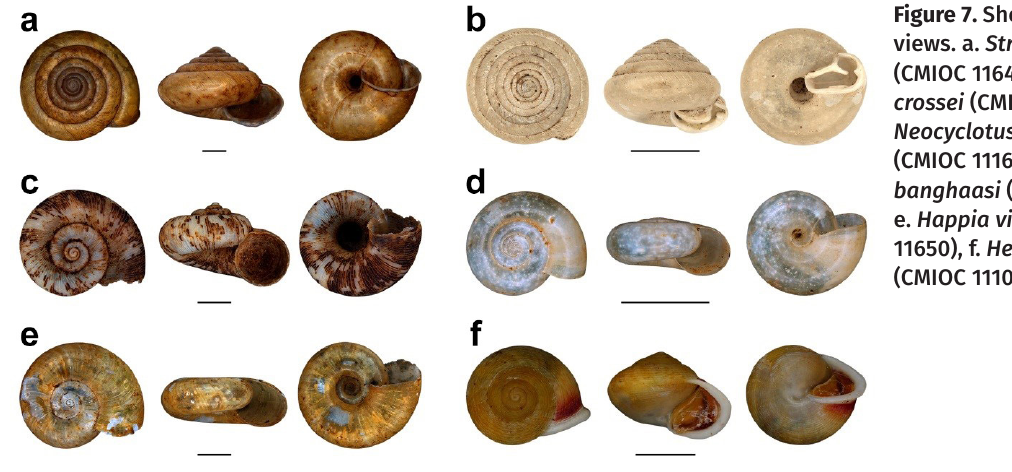
Figure 7. Shell in different views. a. Streptaxis